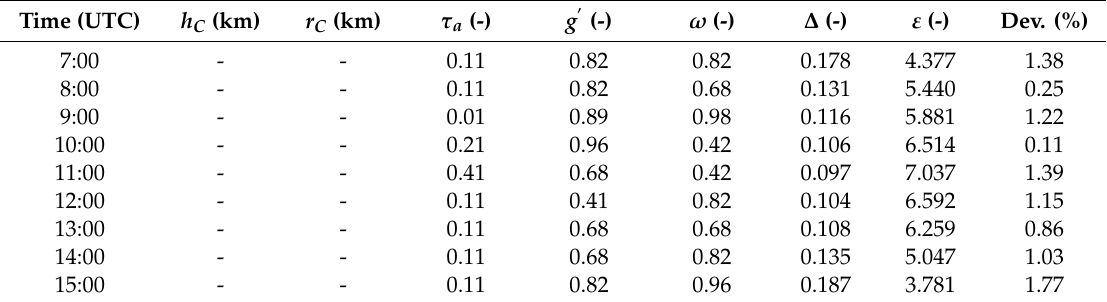
Table 3. The input data to Perez’s all-weather model ( ∆ , ε ) and UMRP model ( h C , r C , τ a , g (cid:48) , ω 0 ) for